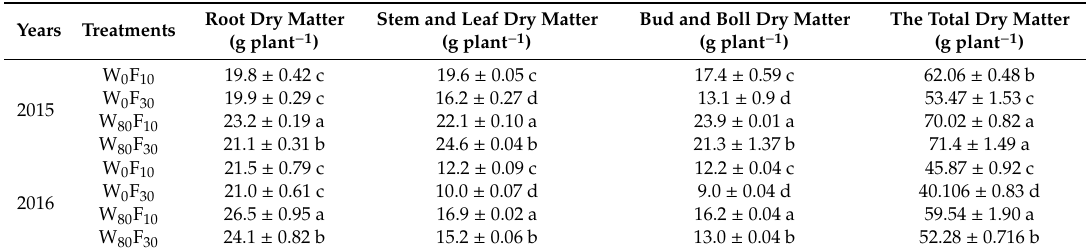
Table 1. Changes in vegetative and reproductive and total organ biomass accumulation under di ff erent irrigation and fertilization during 2015 and